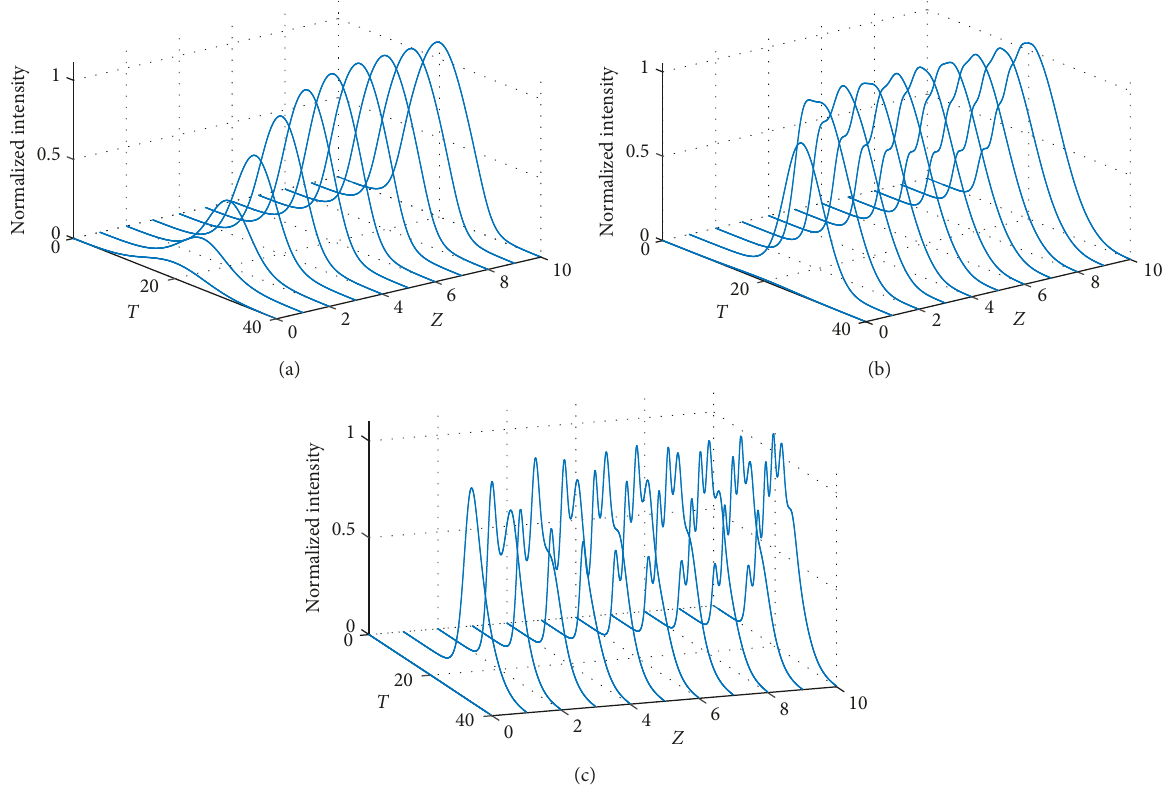
Figure 1: Normalized intensity fluctuations of Stokes pulse with (a) Γ